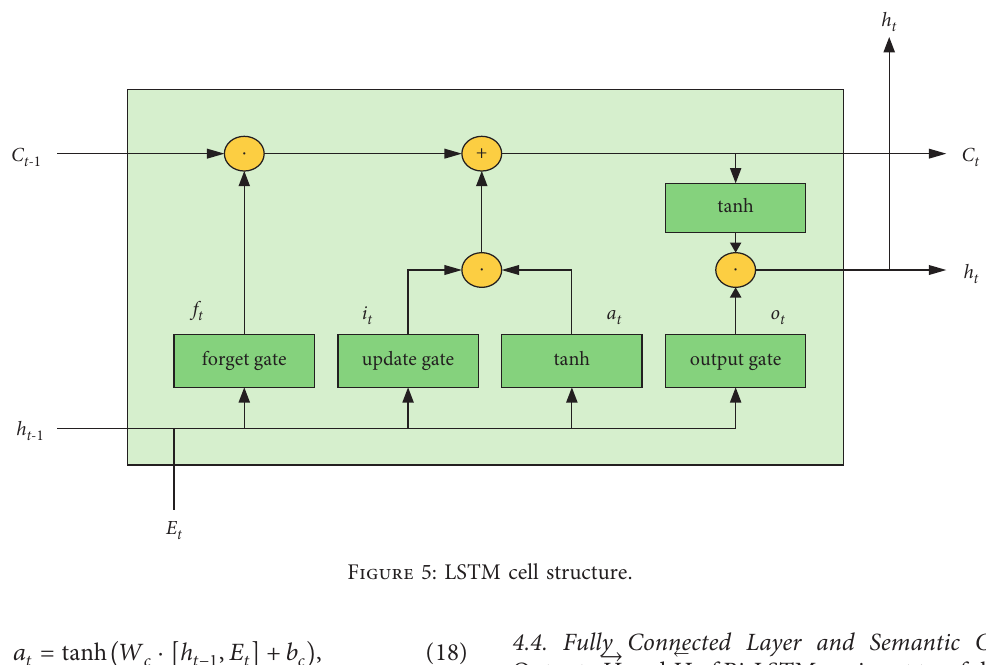
Figure 5: LSTM cell